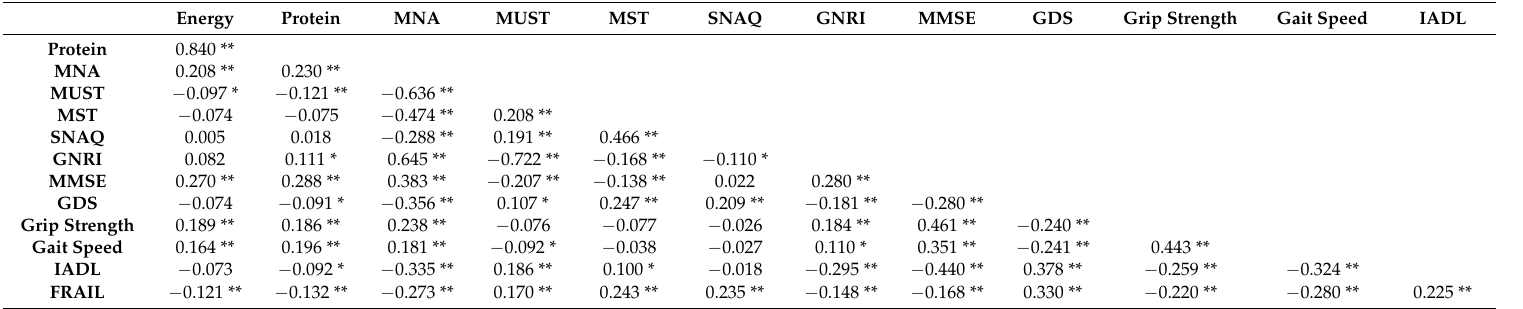
Table 4. Spearman’s rank test between parameters of nutritional status, physical and mental function a . Energy Protein MNA MUST MST SNAQ